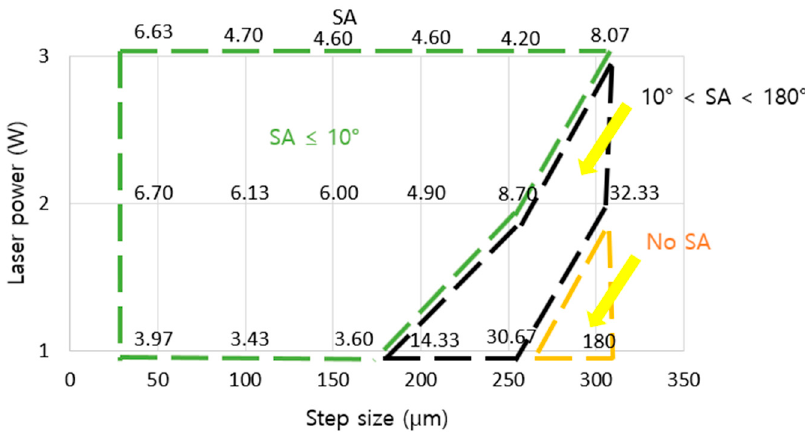
Figure 10. Effect of grid-patterned microstructure on the wetting transition with SA.